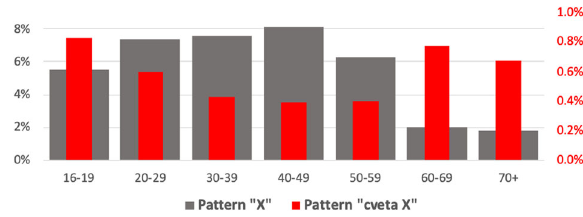
Fig. 13 Frequency of occurrences (%) of color descriptors with the pattern “ cveta X ” ‘ color of X ’ (left axis) and “ X ” (noun-clad adjectives) (right axis) for participants of the seven age groups. Note the difference in the left and right axis